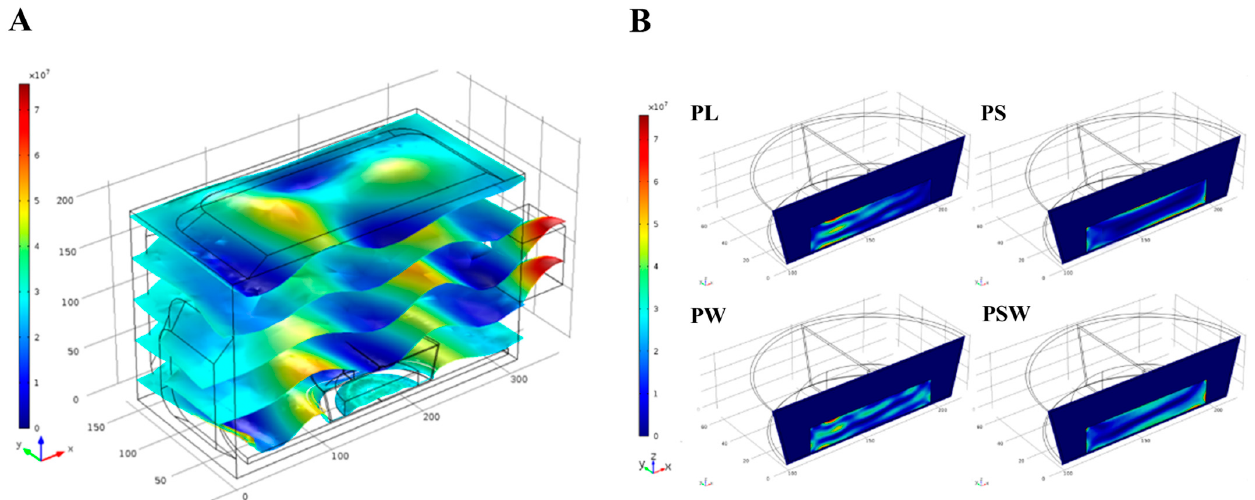
Figure 9. Distribution of the electric field at 700 W inside the microwave oven ( A ) and the cross- section spatial distribution of electromagnetic power density (W/m 3 ) for the pork patties ( B ).